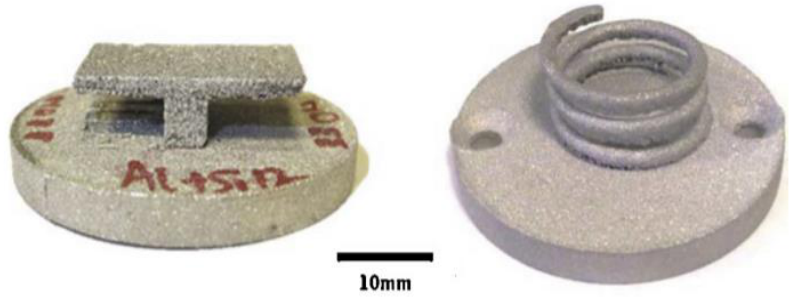
Figure 3. Aluminum silicon alloy produced from SLM on left and ASLM on